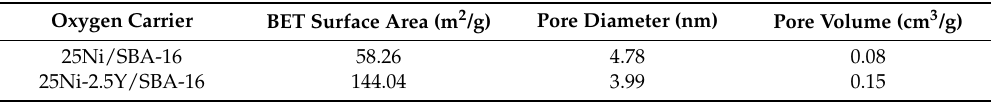
Table 2. Structure characteristics of the spent 25Ni/SBA-16 and 25Ni-2.5Y/SBA-16 oxygen carriers after 16 redox cycles at 650 °C.